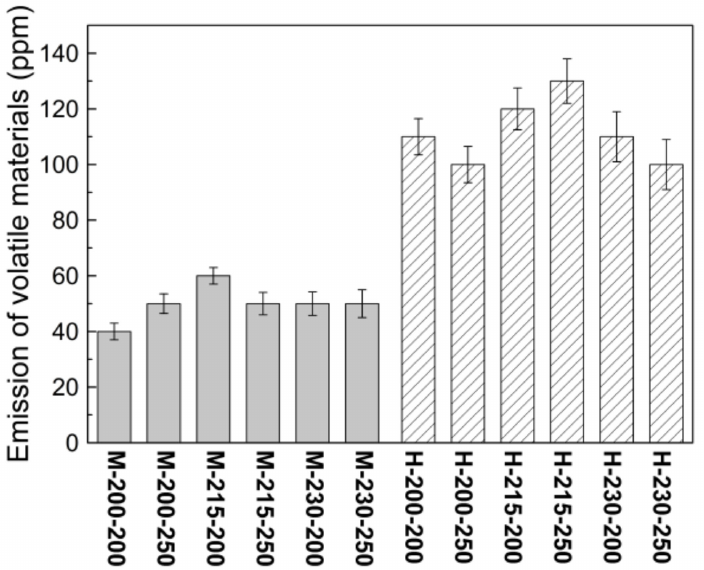
Figure 9. Comparison of amounts of evaporated volatile materials in extruded CR-PP samples under various extrusion